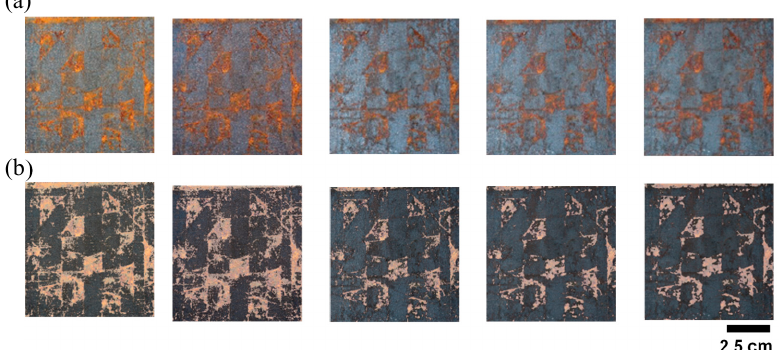
Figure 7. Test images of partially corroded steel plates acquired at different illuminations of natural daylight. ( a ) ground truth images, ( b ) MLP-based corrosion prediction.